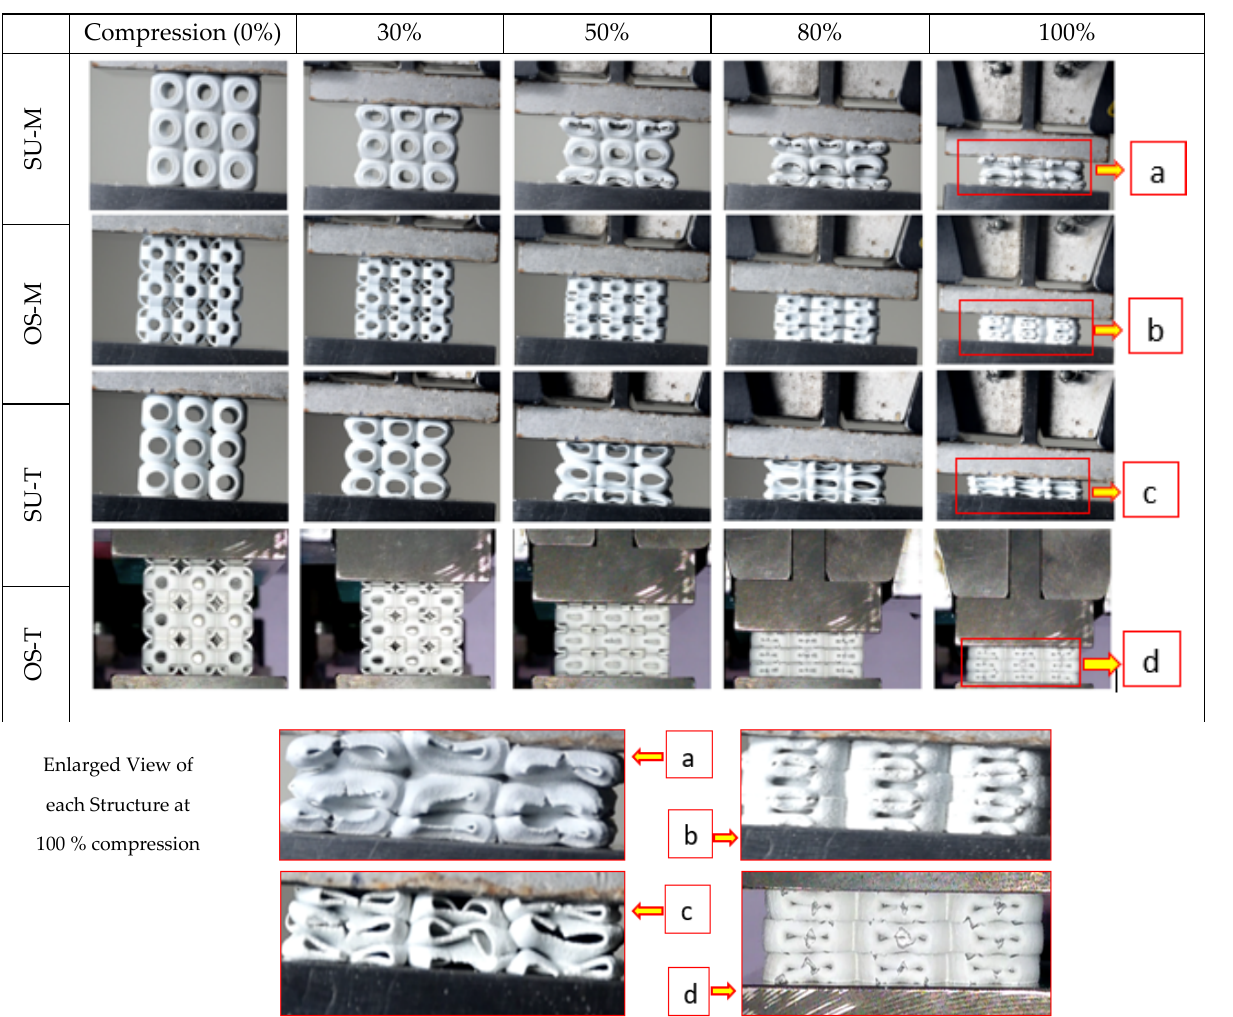
Figure 6. Performance of SU and OS structures with M and T at various stages under progressive compression—from left to the right side—(above), enlarged complete densification stage of each structure shown failure mechanism (below). ( a ) SU-M structure at 100% compression; ( b ) OS-M structure at 100% compression; ( c ) SU-T structure at 100% compression; ( d ) OS-T structure at 100%